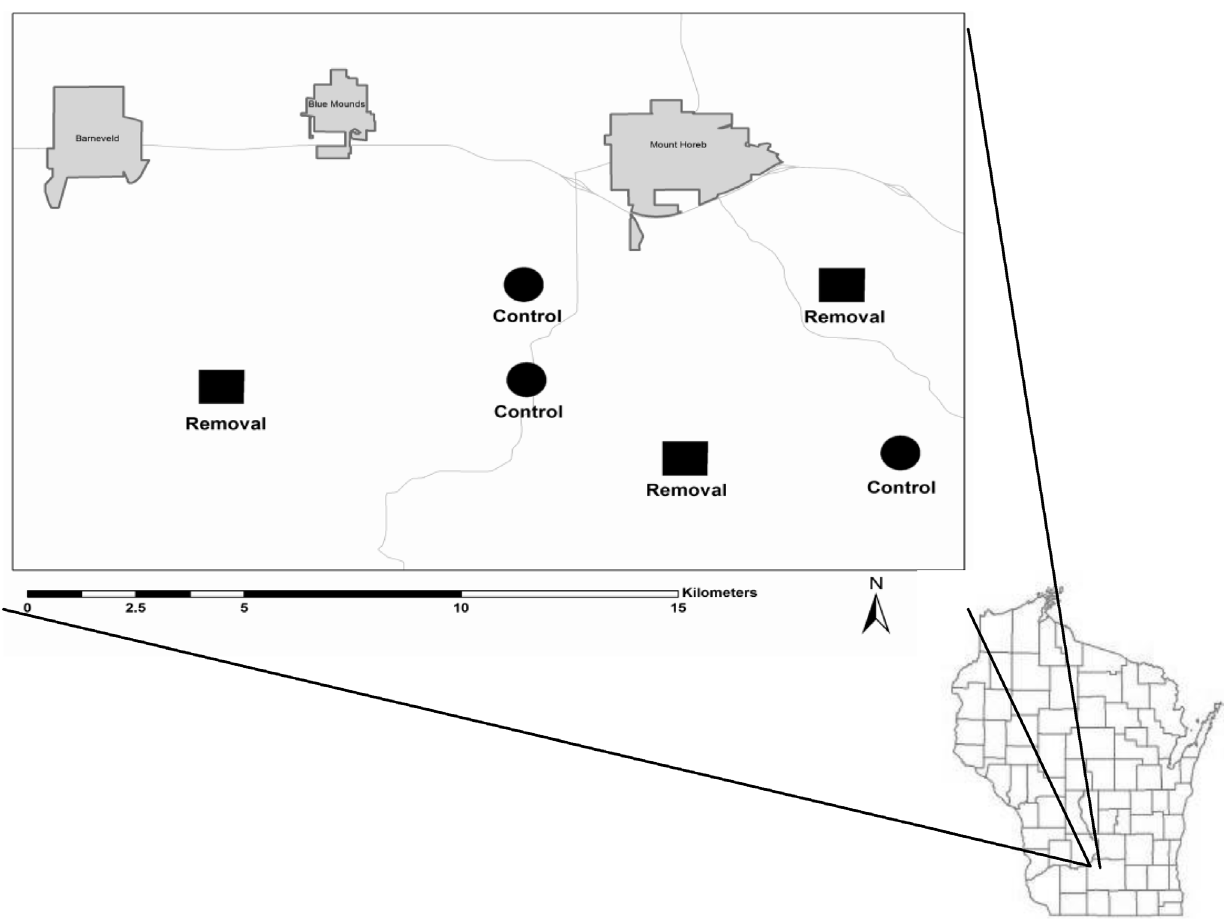
Figure 1. Study site locations in southwestern Wisconsin. Squares and circles indicate sites used for tree row removals and controls, respectively. Shaded polygons depict developed areas, labeled by town name. Lines represent major highways.